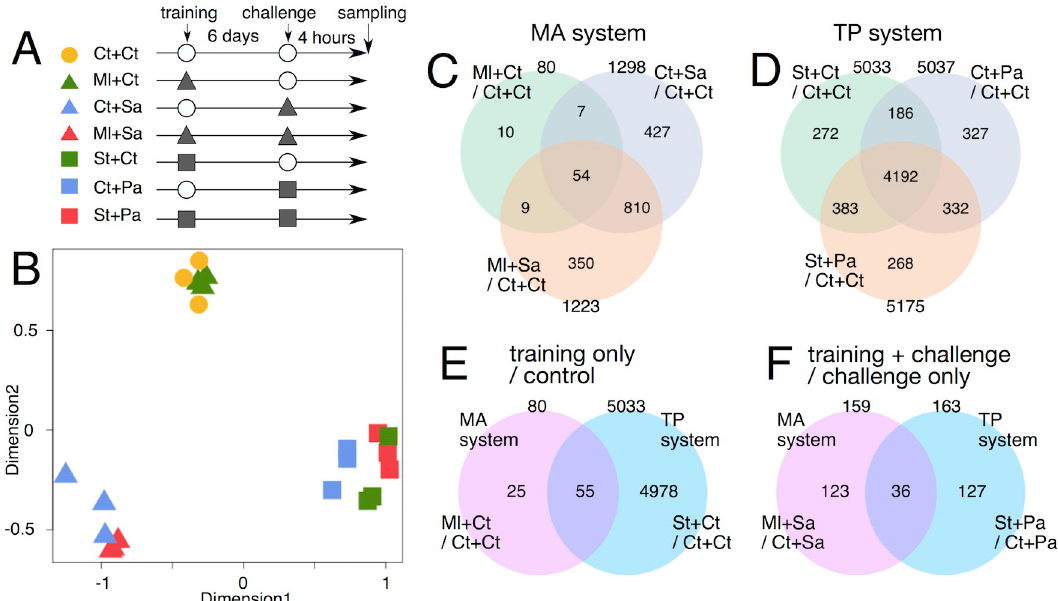
Fig 3. Overall features of transcriptomes for immune training. (A) Schematic drawing of the experimental schedule. Empty circles and filled symbols represent saline- and bacteria-injection, respectively. (B) MDS analysis of transcriptomes for all samples. Distance between plots correlates to the similarity of transcriptomes between samples. (C, D) Venn diagrams for DEGs detected from pair- wise comparisons against the control condition in MA system (C) and in TP system (D). (E, F) Venn diagrams for DEGs detected for training only against the control condition (E) and for training + challenge condition against challenge only condition (F) in MA and TP systems. The gene IDs of DEGs are listed in S3 Table.